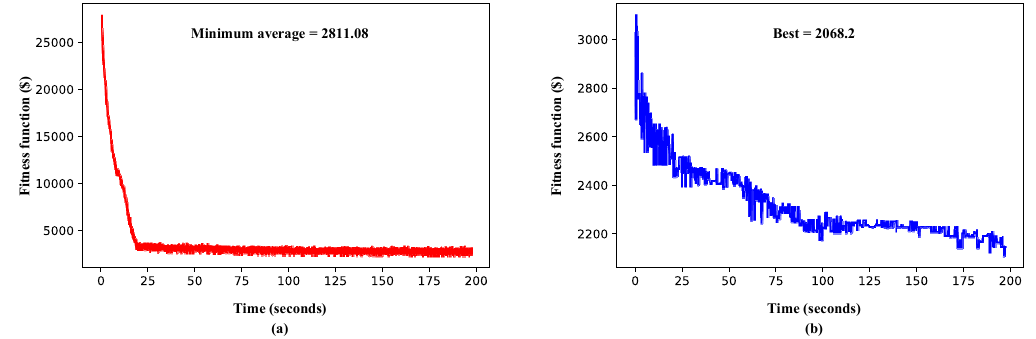
Fig. 12. (a ) The change with time of the average fitness function in HGA-VNS for the normal demand fulfillment, (b) The change with time of the best fitness function in HGA-VNS for the normal demand fulfillment As seen in Table 12, the best objective function was obtained with the HGA-VNS algorithm for the normal demand fulfillment. The routes that were found in the HGA-VNS algorithm to fulfill the normal demand were shown in Fig. 13.